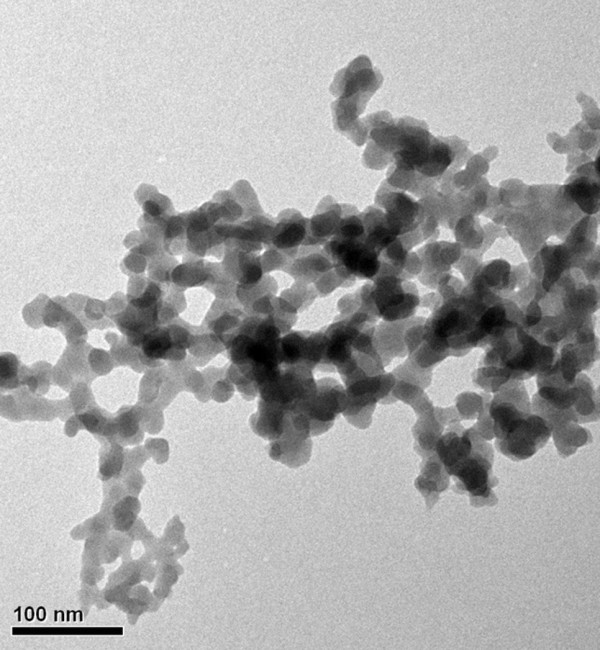
TEM image of SiO2 additives.